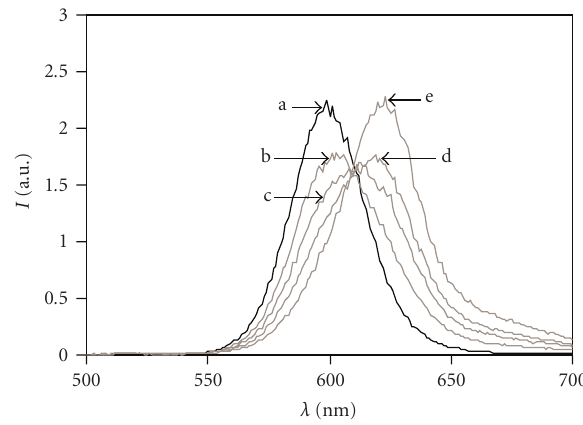
Figure 8: Emission spectra of CdSe-ZnS core-shell QDs (0.1 μ M in borate bu ff er, pH = 7.4, T = 20 ◦ C, λ EX = 442nm) in the absence (a) and presence of 1.0 (b), 3.0 (c), 5.0 (d), and 10.0 (e) μ M of BODIPY-